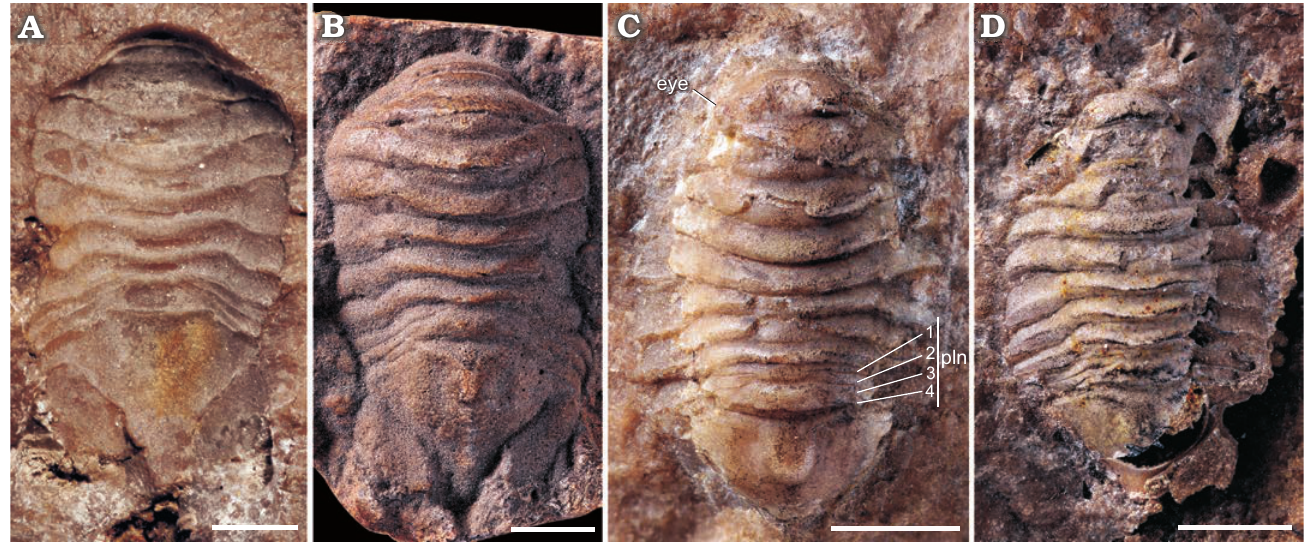
Fig. 1. Dorsal views of isopod Heterosphaeroma priscum (Milne-Edwards, 1868), late Thanetian of Sézanne, Marne, France. A . SU.PAL.2017.0.2.61 (outer mold, holotype). B . MNHN.F.B71849 (plaster cast of lost SU.PAL.2017.0.2.61, inner mold). C . SU.PAL.2017.0.2.3.1. D .